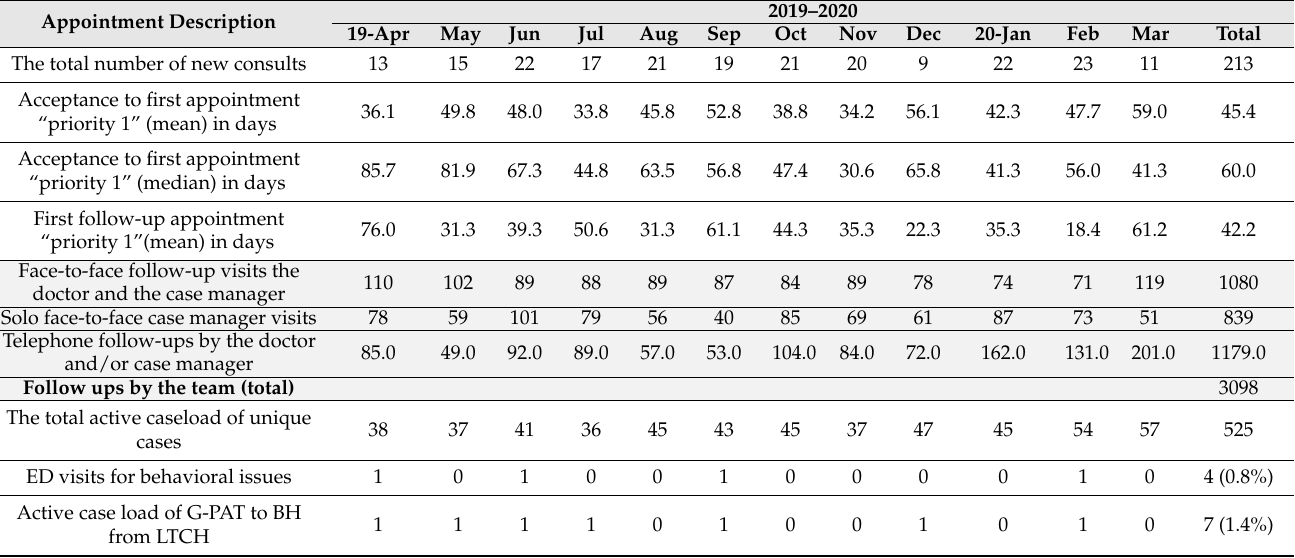
Table 3. The timelines for the initial assessment and first follow-up visits for